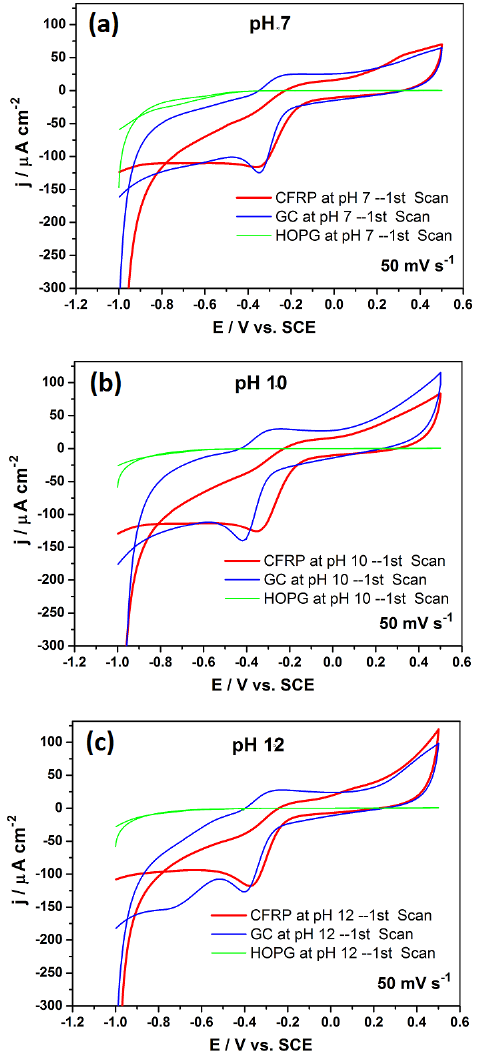
Figure 3. Comparison of cyclic voltammograms of CFRP, HOPG, and glassy carbon in 50 mM NaCl adjusted to pH 7 ( a ), 10 ( b ), and 12 ( c ) respectively, and at scan rates of 50 mV s −1 .